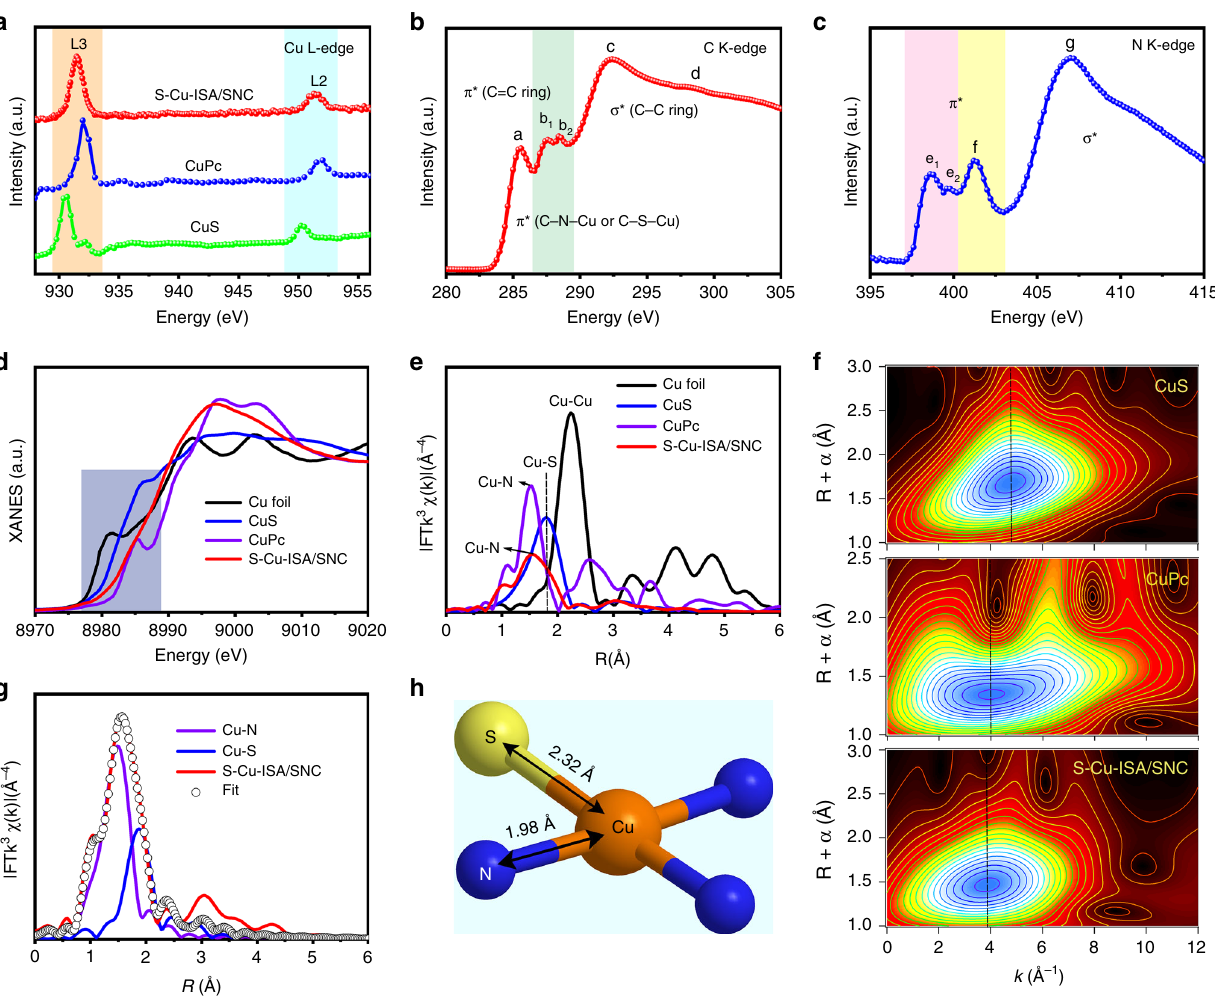
Fig. 2 Chemical state and atomic local structure of S-Cu-ISA/SNC. a Cu L-edge XANES spectra of S-Cu-ISA/SNC, CuS and CuPc. b C K-edge and c N K-edge XANES spectra of the S-Cu-ISA/SNC. d The experimental Cu K-edge XANES spectra of S-Cu-ISA/SNC and the references (Cu foil, CuS and CuPc). e FT k 3 -weighted Cu K-edge EXAFS spectra of S-Cu-ISA/SNC and the references. f WT-EXAFS plots of S-Cu-ISA/SNC, CuS and CuPc, respectively. g FT- EXAFS fi tting curves of S-Cu-ISA/SNC at Cu K-edge. h Schematic atomic interface model of